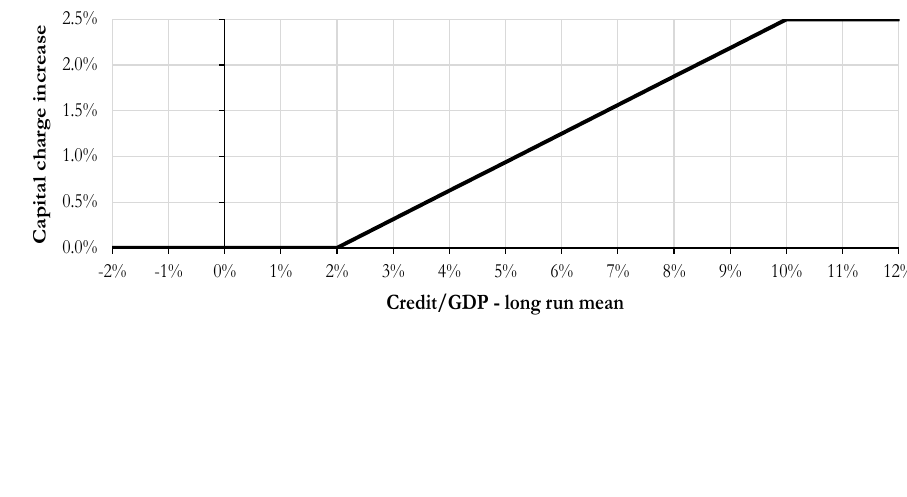
Relationship between the countercyclical capital buffer and the credit-to-GDP gap